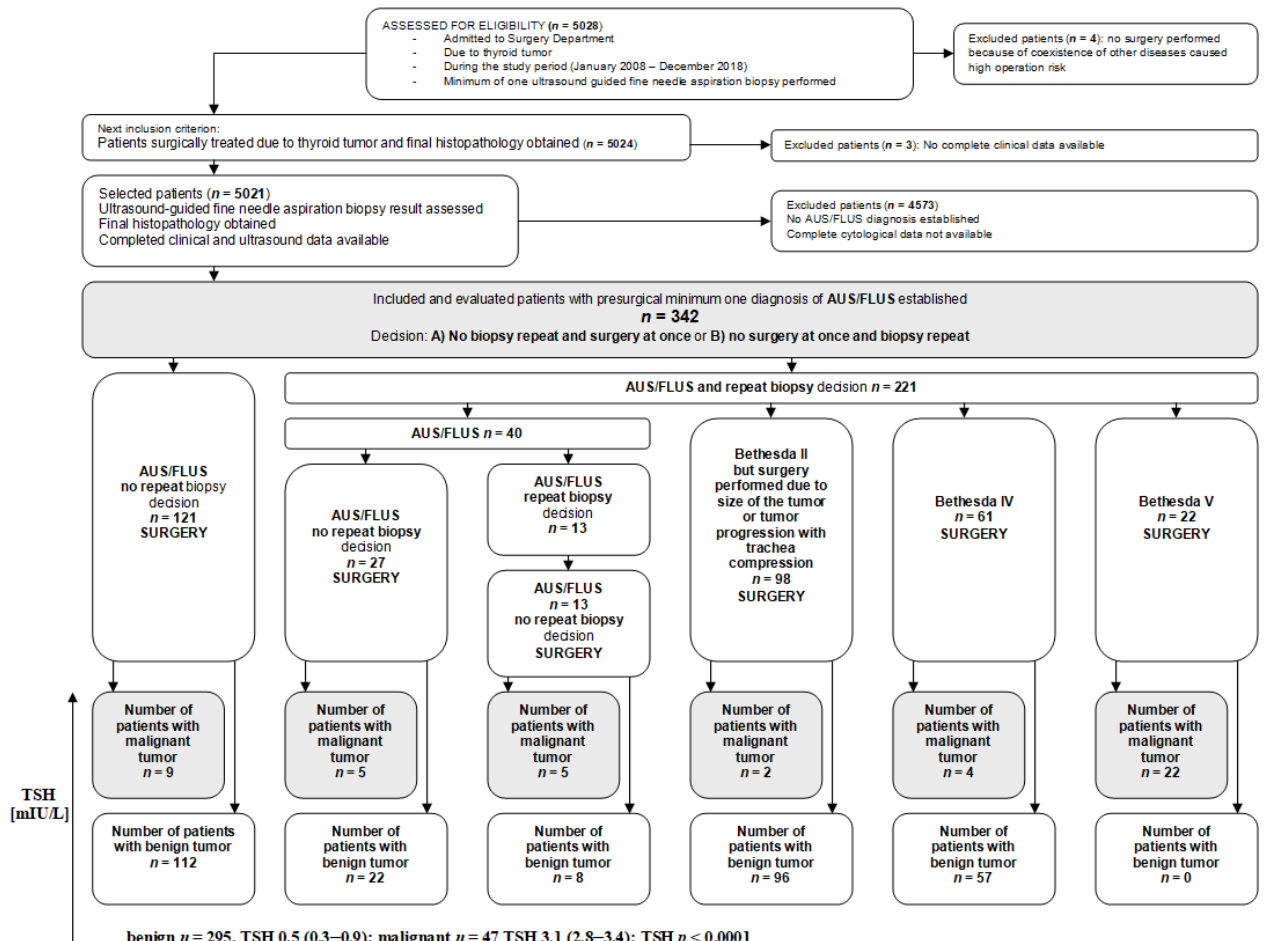
Figure 1. Selection of the study group from 5028 individuals referred for surgery from 2008 to 2018. All participants underwent a minimum of one UG-FNAB with a minimum of one AUS/FLUS diagnosis. All evaluated patients underwent surgery, and histopathology results were obtained in all cases. TSH serum levels were assessed before surgery in all patients.